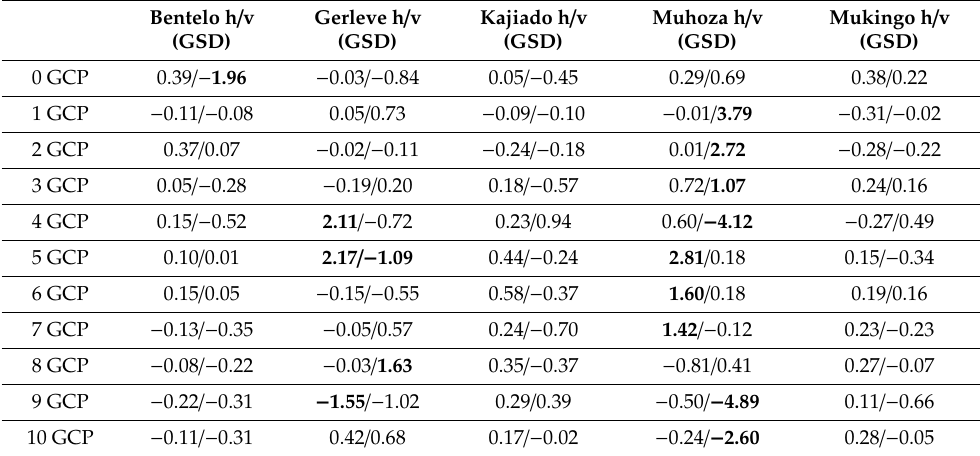
Table5. Di ff erencesofRMSEofcheckpointresidualsmeasuredaftertheBBAandintheorthophoto / DSM. Values are normalized, according to GSD. Horizontal (h) and vertical (v) errors are treated separately. Di ff erences > 1 GSD are indicated bold.